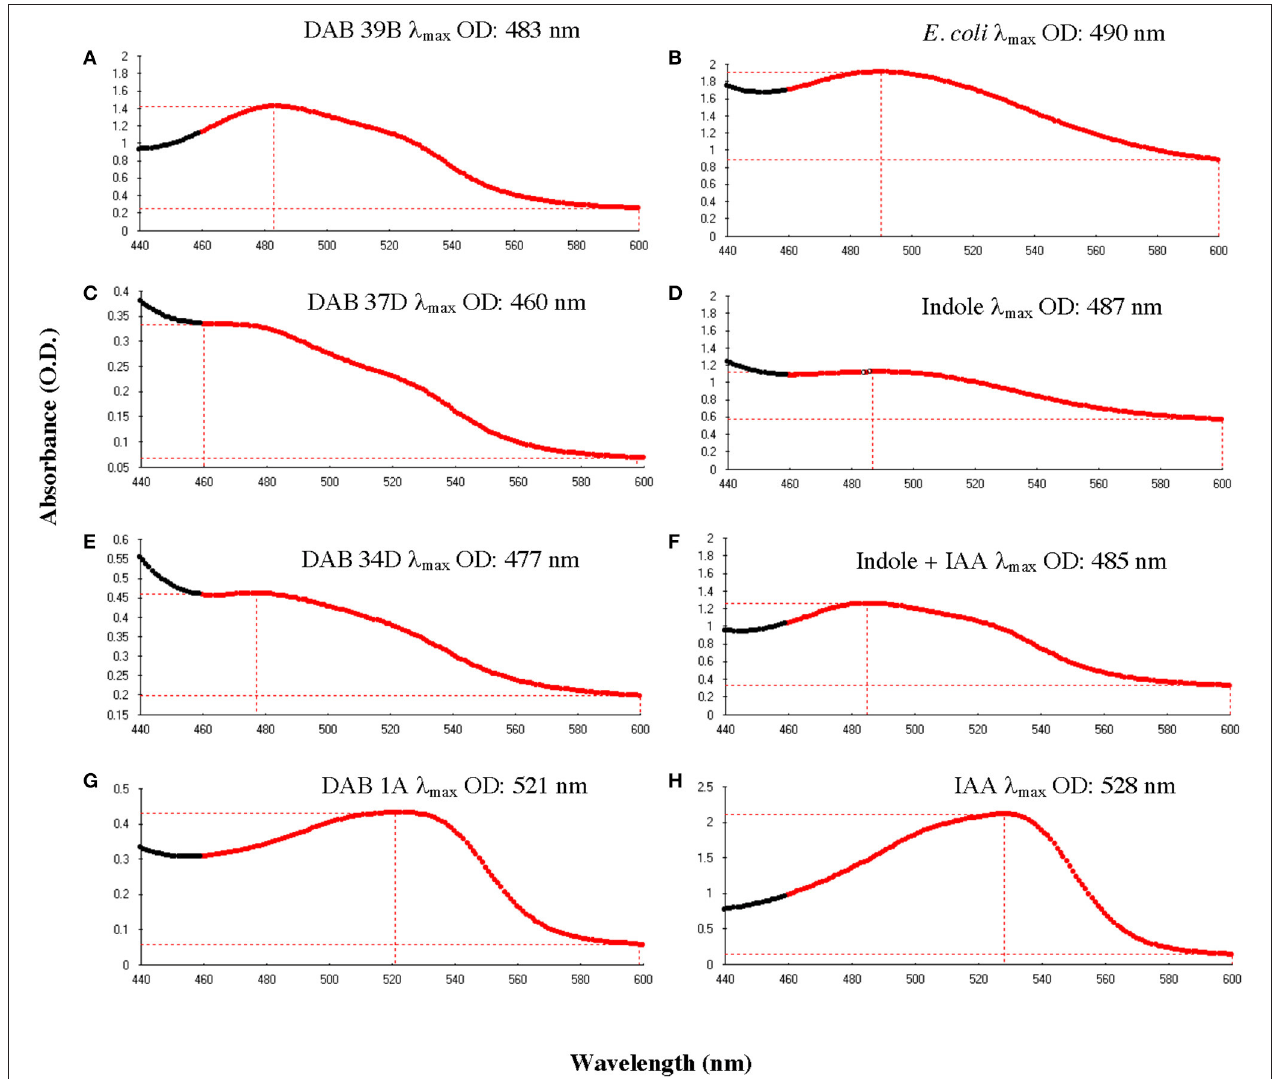
FIGURE 5 | Comparison of absorbance spectra between DABs and other reference samples with the Salkowski assay. Absorbance spectrums from 440 to 600nm to determine the wavelength at the maximum OD ( λ max ). (A) Brown-type Aeromonas strain, DAB 39B, has a λ max at 483nm and a minor peak at around 530nm. (B) Known indole-producing E. coli strain, DH5 alpha, has a λ max at 490nm. (C) Brown-type Chryseobacterium strain, DAB 37D, has a λ max at 460nm and a minor peak at around 530nm. (D) An LB solution containing 1 mg/mL of free indole has a λ max at 487nm. (E) Brown-type Vogesella strain, DAB 34D, has a λ max at 477nm and a potential minor peak at around 530nm. (F) An LB solution containing a mixture of 1 mg/mL of free indole and 0.1 mg/mL of free IAA has a λ max at 485nm. (G) Pink-type Microbacterium strain, DAB 1A, has a λ max at 521nm. (H) An LB solution containing 0.1 mg/mL of free IAA has a λ max at